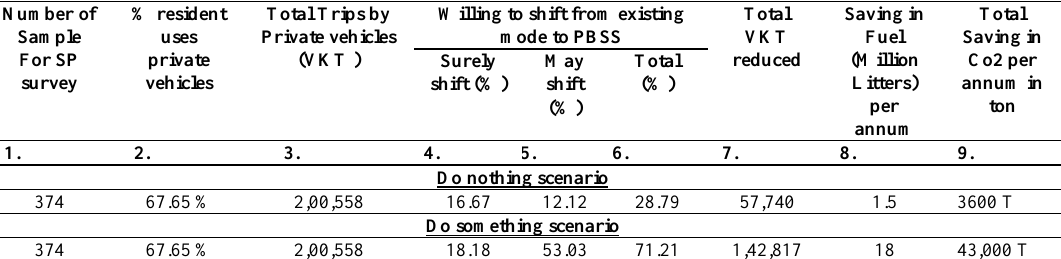
Table 6. Analysis of shift behavior due to policy